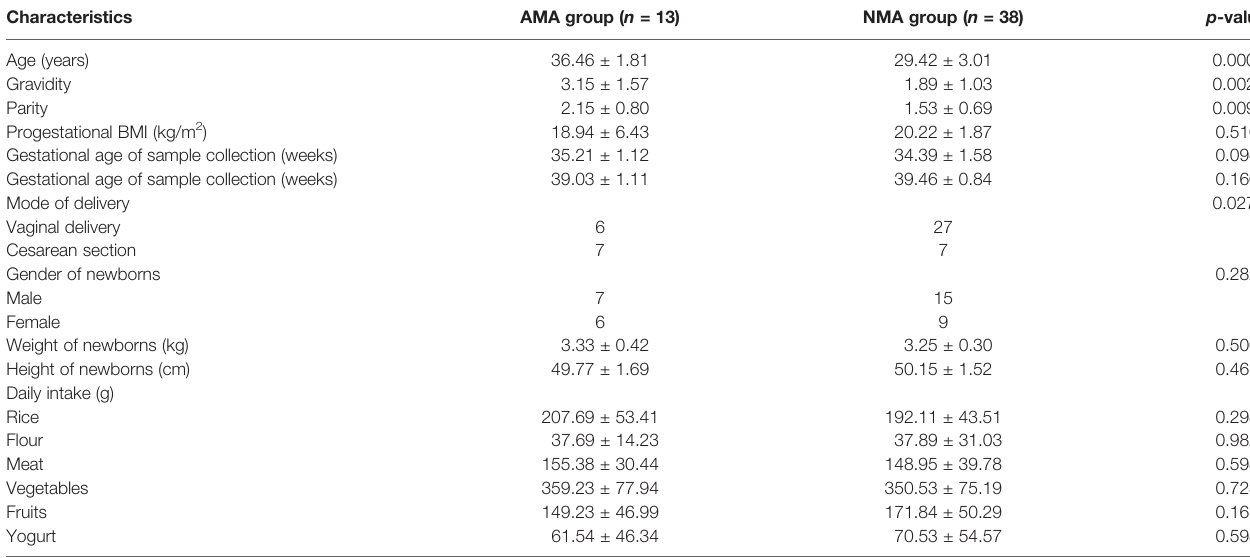
TABLE 1 | Clinical and anthropometric characteristics of the mothers and their newborns.